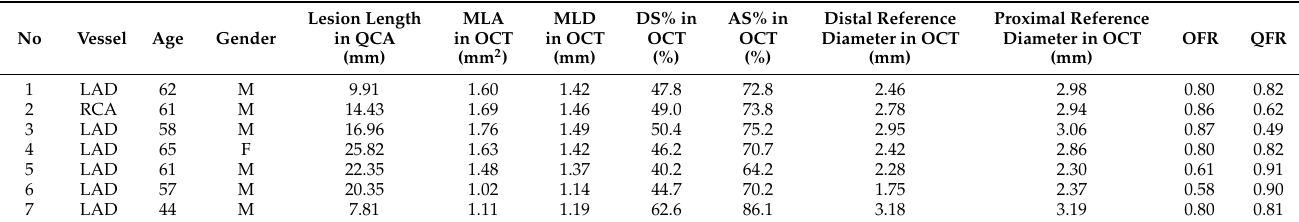
Table 4. The patient’s hemodynamics differences between OFR and